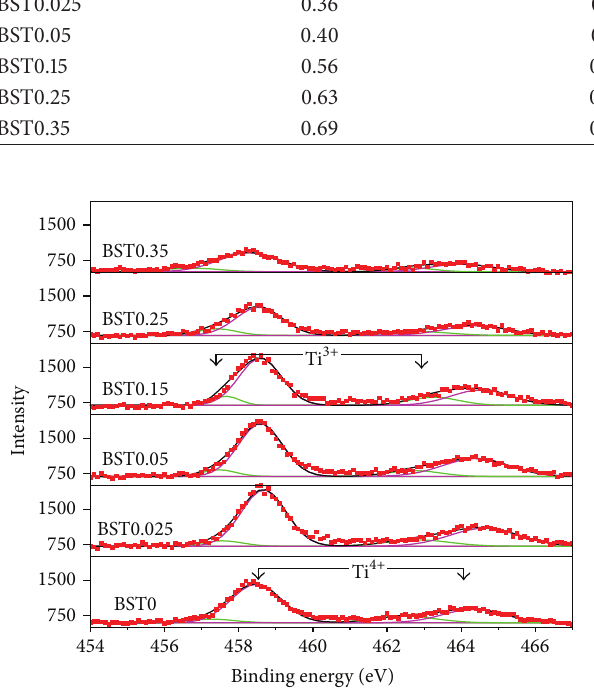
Figure 8: The fitting XPS spectra of Sr 3d deconvolution with Gaussian function.